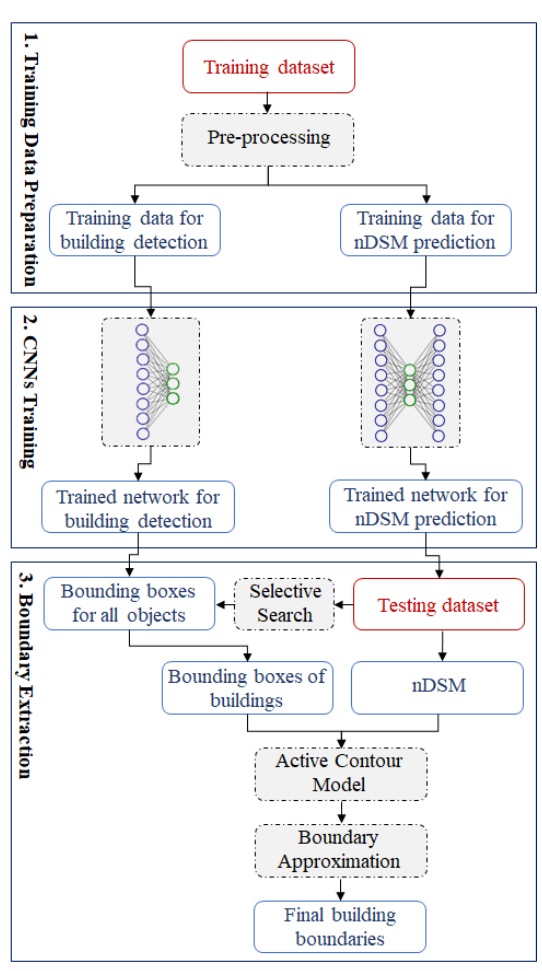
Figure 1. The proposed